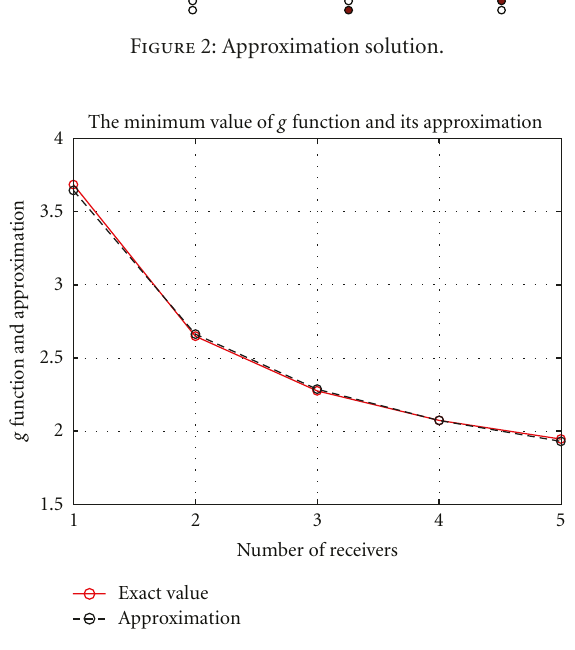
Figure 3: Approximation of G function.